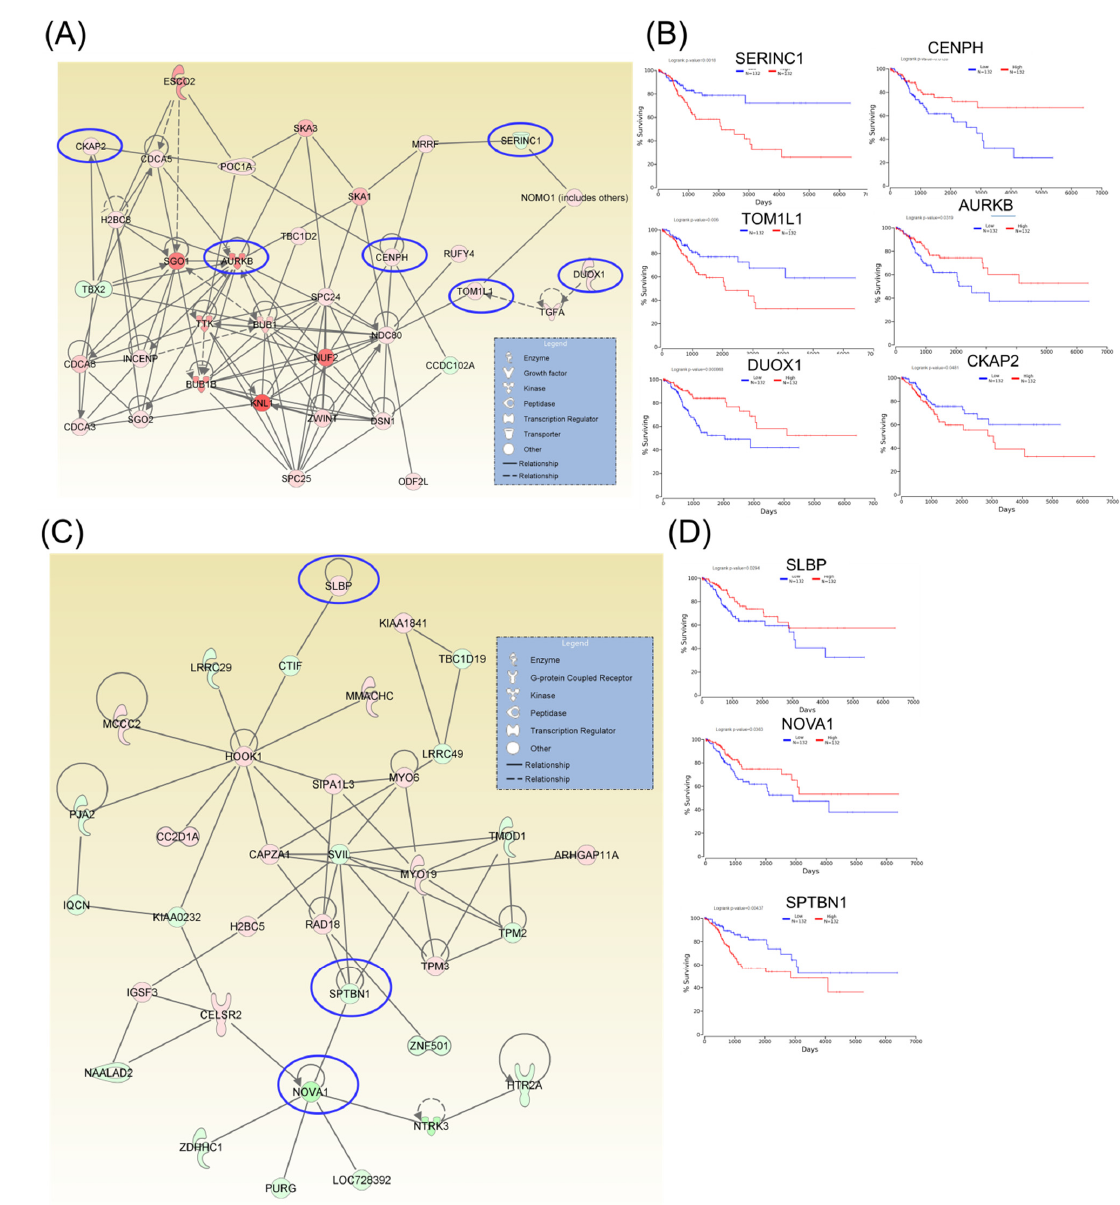
Figure 3. A signaling network analysis using the IPA software for differentially expressed genes in CC. ( A ) Network 1: Cell Cycle; Cellular Assembly and Organization; and DNA Replication, Recombination, and Repair. ( B ) Genes predicting overall survival in network 1. ( C ) Network 2: Cellular Assembly and Organization. ( D ) Genes predicting overall survival in Network 2; red: overexpressed genes, green: downregulated genes, blue circles are for genes predicting overall survial rate in CC